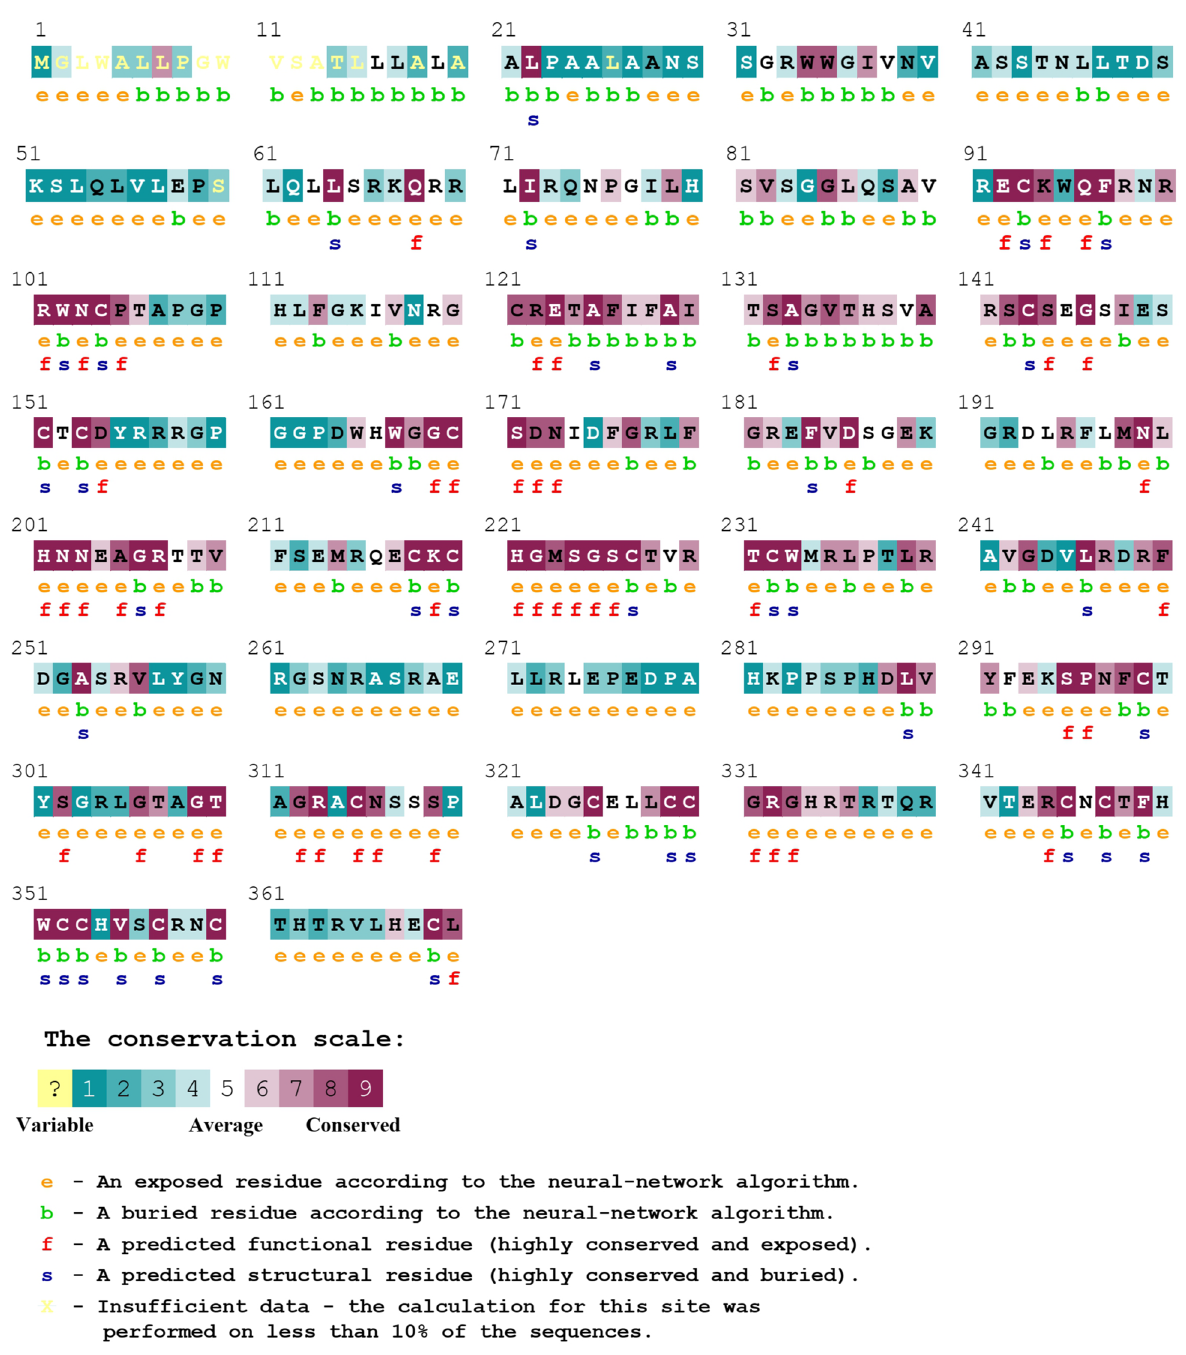
Figure 1. Evolutionary conservation profile of human Wnt1 by ConSurf. The color coding bar shows the coloring scheme representation of conservation